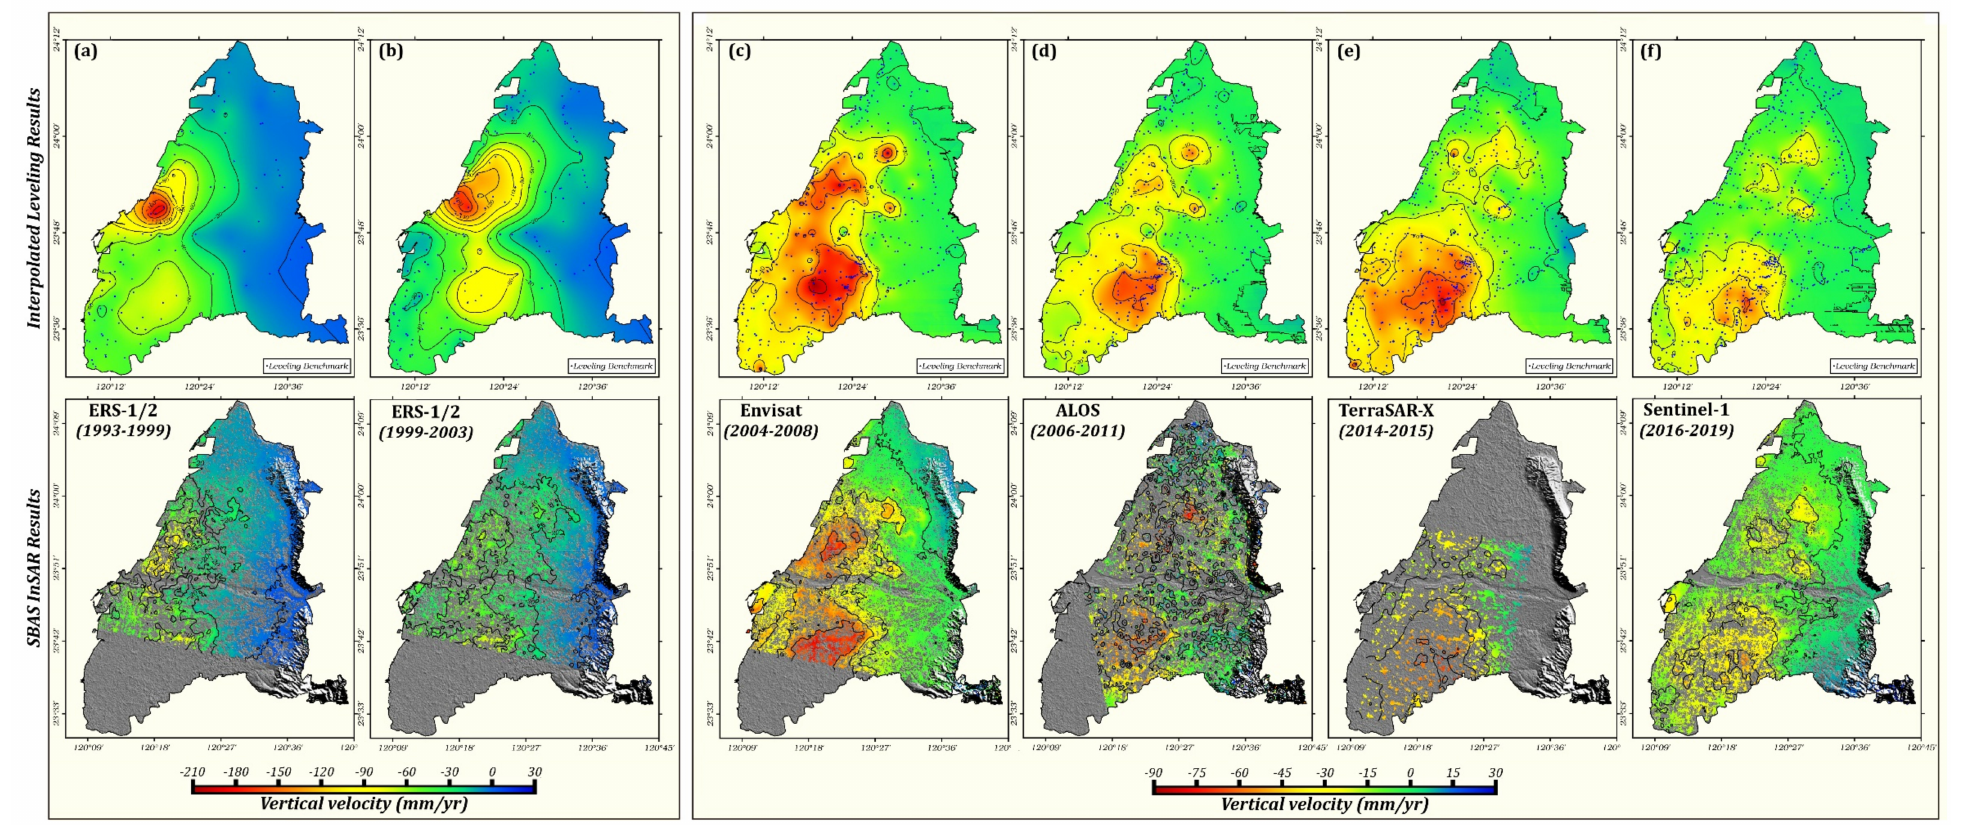
Figure 5. Average vertical velocities from precise leveling (upper row) and SBAS InSAR measurements (bottom row) over six periods ( a – f ). Positive values (cold color) indicate uplift, and negative values (warm color) indicate land subsidence. The interval of the contour lines is 20 mm/yr. The blue dots denote the leveling